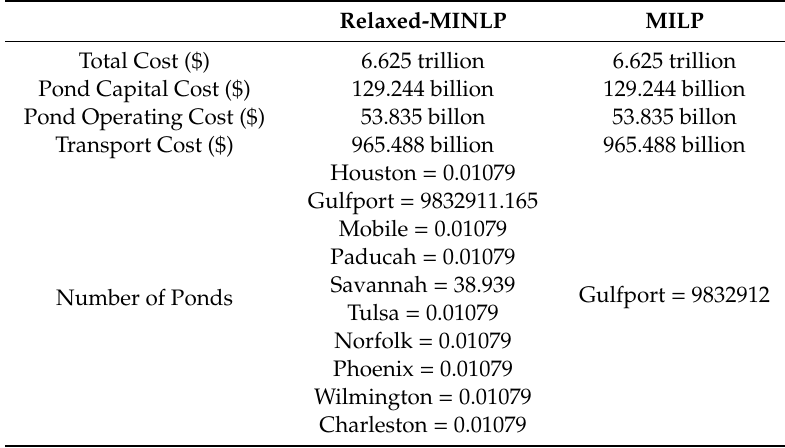
Table 9. Comparison of the solution from relaxed-MINLP and MILP solvers: CONOPT 3 version 3.17 A and CPLEX version 12.6.3.0 for the U.S. case.